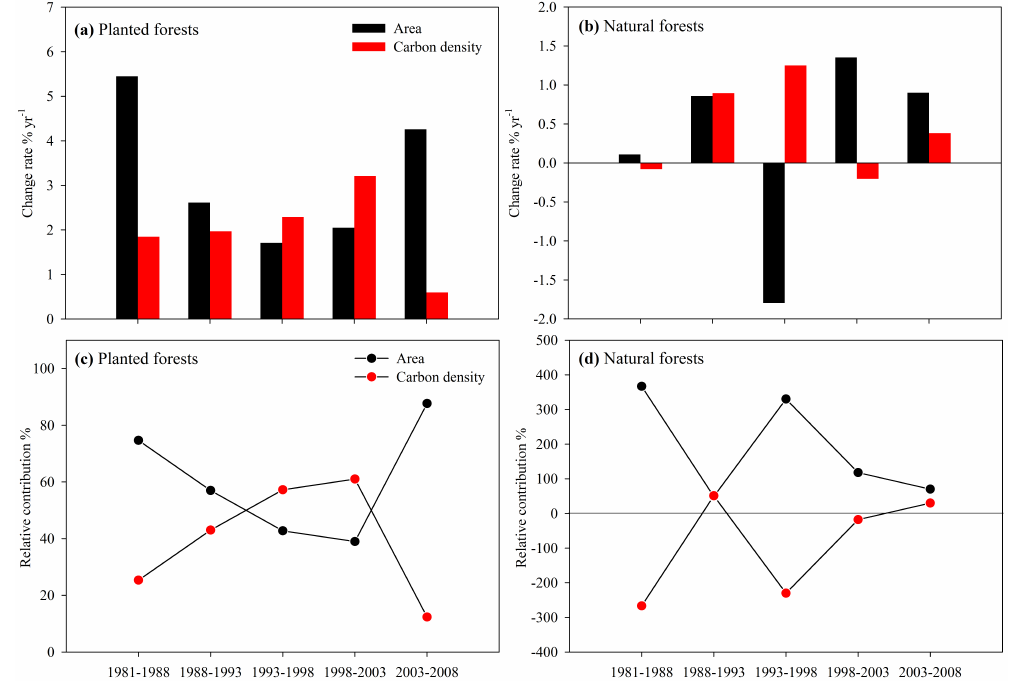
Figure 2. Relative contributions and the dynamics of areal expansion and forest growth to carbon sinks in planted ( a and c ) and natural ( b and d ) forests of China in the period 1977–2008. Bars and points represent the rates of change and the relative contributions of forest area (in black) and carbon density (in red),